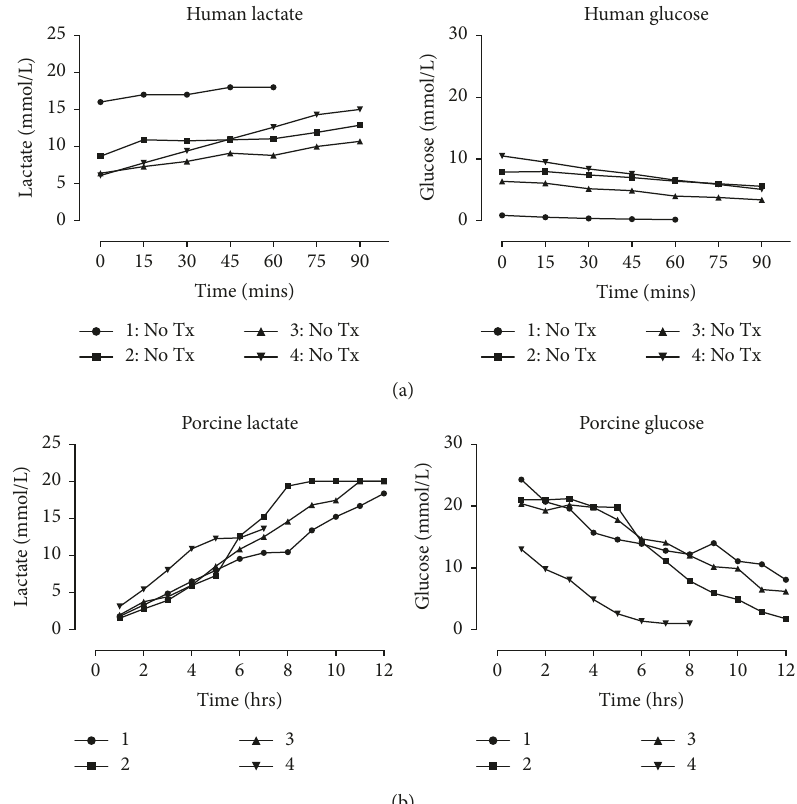
Figure 6: (a) Human and (b) porcine EVLP perfusate glucose and lactate